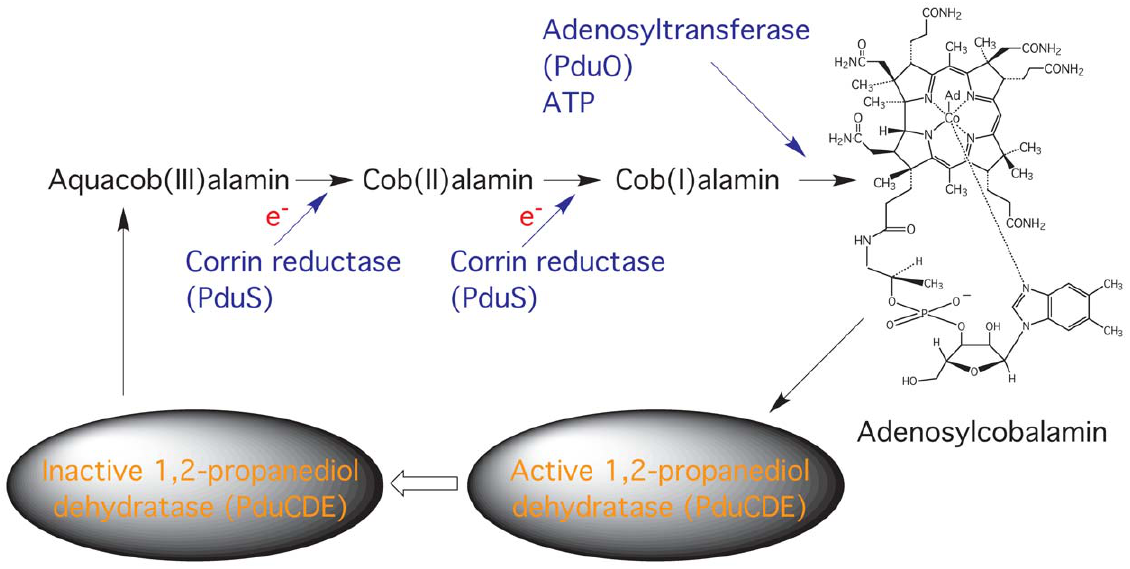
Figure 1. Regeneration of adenosylcobalamin from aquacobalamin. In the 1,2-propanediol utilisation metabolosome the adenosylcoba- lamin-dependent diol dehydratase (PduCDE) occasionally generates aquacobalamin. This inactivated form of the coenzyme is reactivated by the action of a corrin reductase, PduS, and an adenosyltransferase (PduO). This is achieved by two sequential one-electron reductions of aquacob(III)alamin to cob(I)alamin prior to the transfer of the adenosyl moiety from ATP.